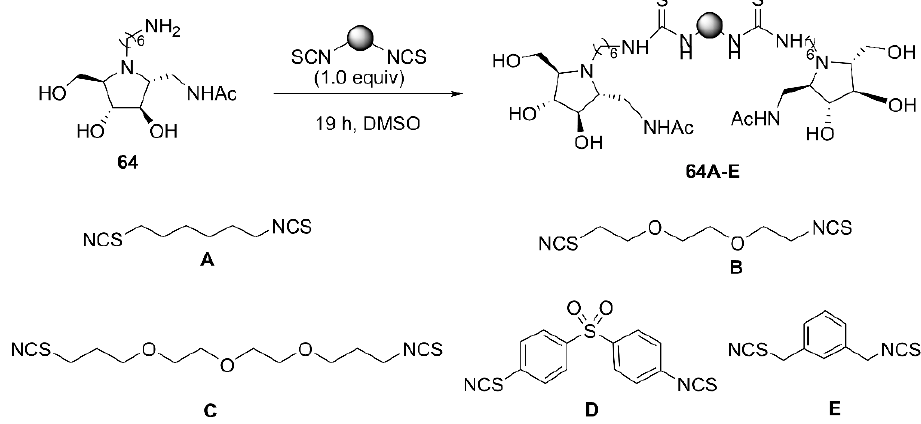
Scheme 10 . Synthesis of divalent iminosugars 64A – E